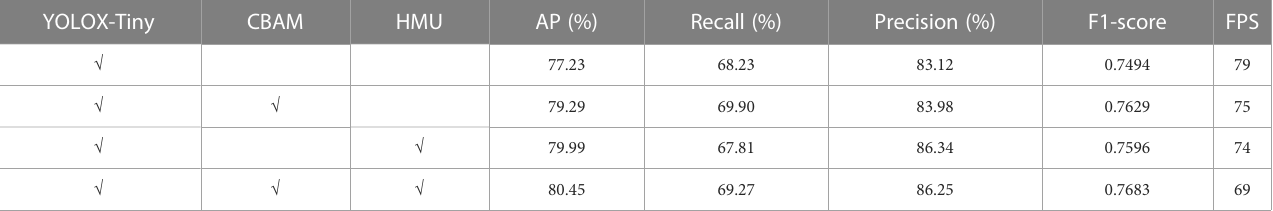
TABLE 3 The results of ablation experiments with the con fi dence threshold is 0.5 and the IOU is 0.5. YOLOX-Tiny